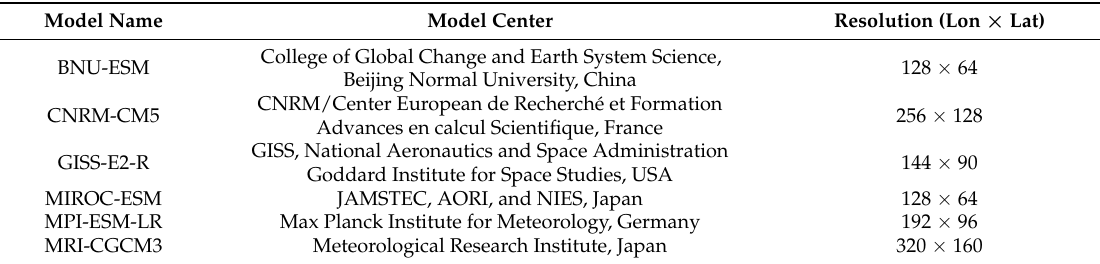
Table 1. Information of six